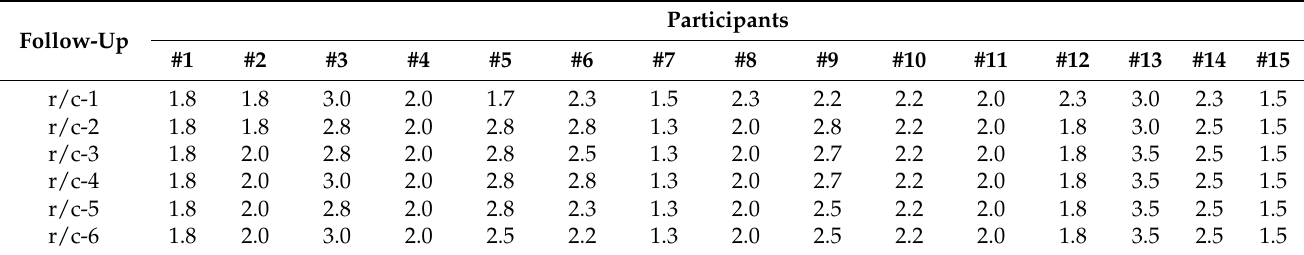
Table 3. Periodontal probing depth (mm) around a single-unit restoration for each participant during 6-month follow-up. Follow-Up